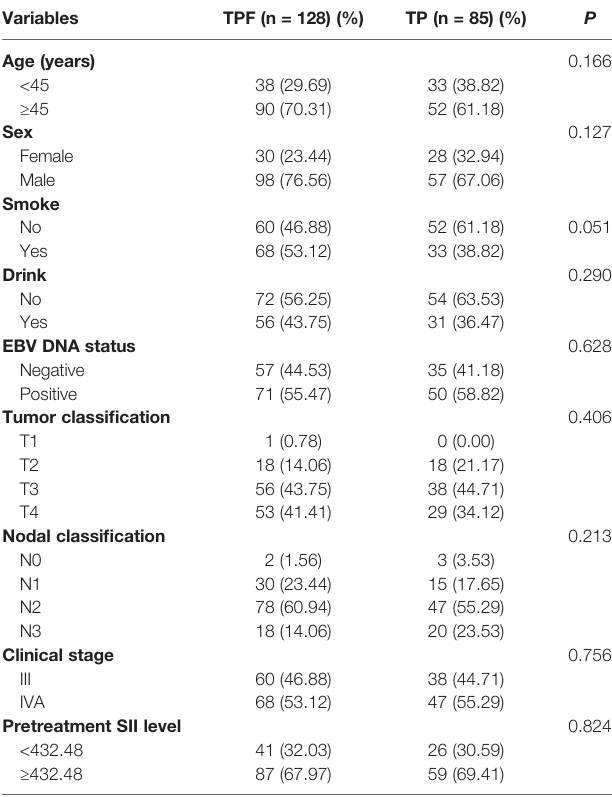
TABLE 1 | Baseline characteristics of patients in the TPF and TP groups. Variables